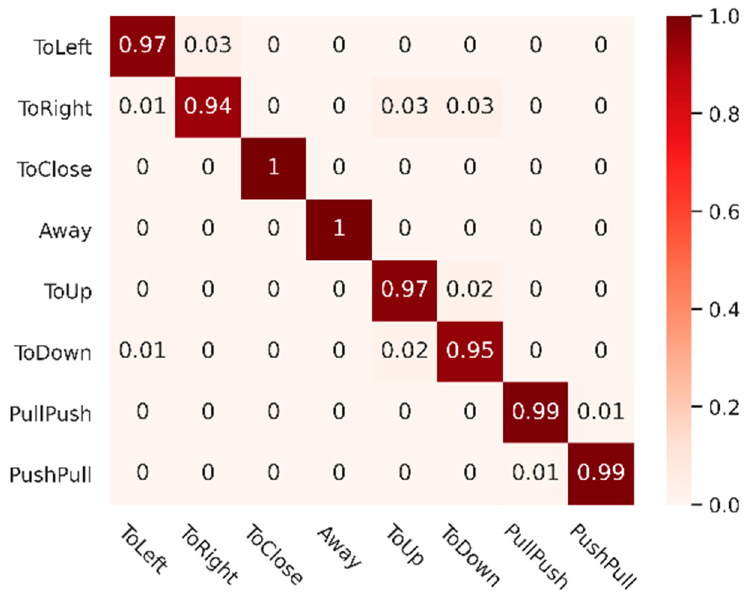
Figure 14. Confusion matrix of RGTNet with our dataset.